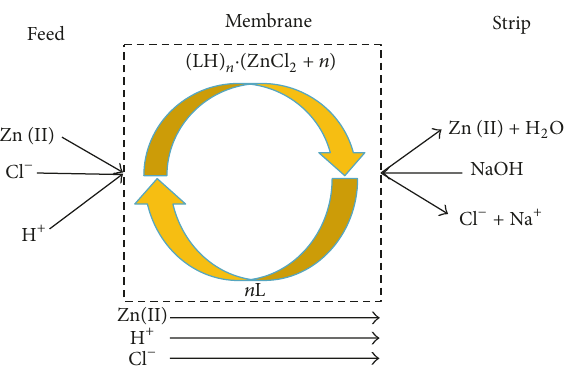
Figure 1: Transport mechanism of Zn (II) through supported liquid membrane.